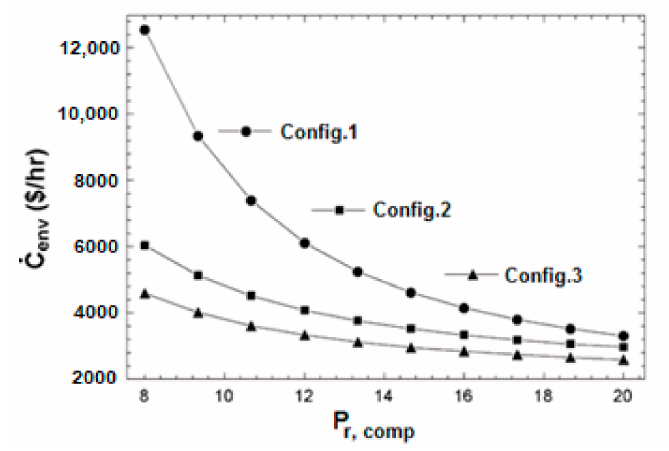
Figure 7. Effect of compressor pressure ratio change on the environmental cost rate.